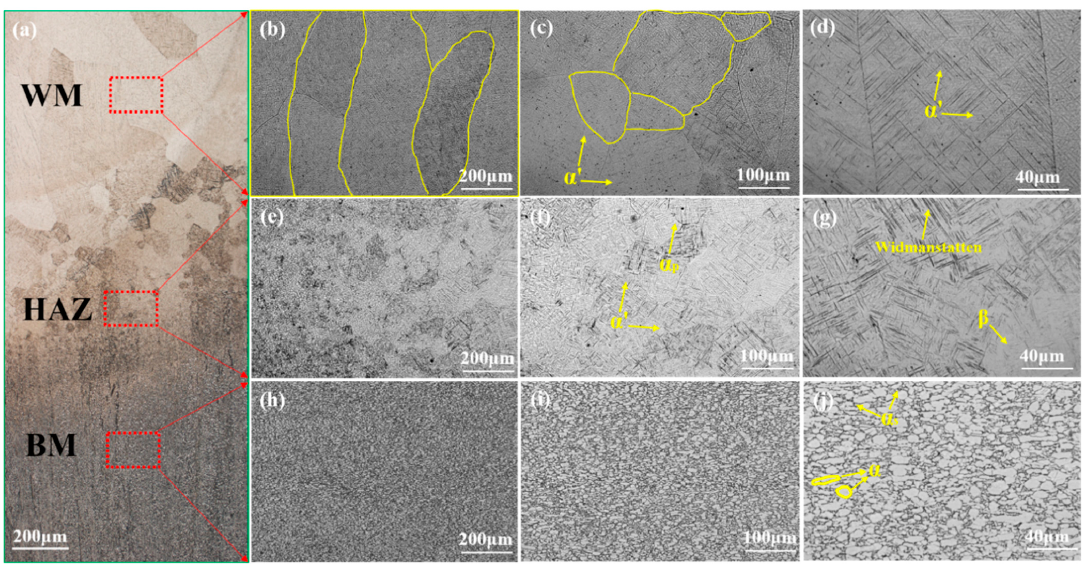
Figure 3. Microstructure of welded joint: ( a ) overall micromorphology; ( b – d ) WM; ( e – g ) HAZ; ( h – j ) BM.